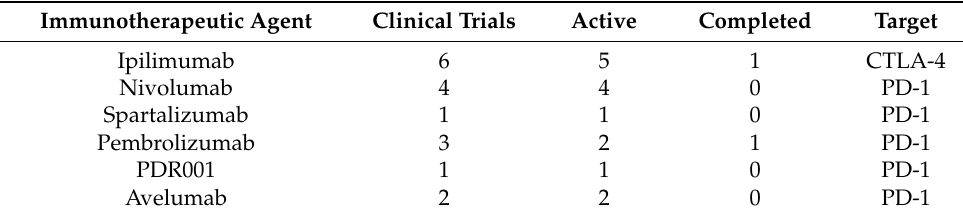
Table 6. Immunotherapy-clinical